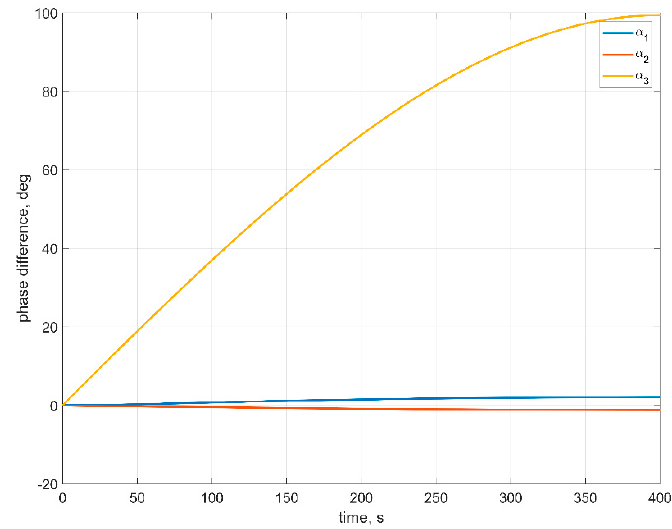
Figure 9. Phase difference between uniform and numerical RW angle evolution.